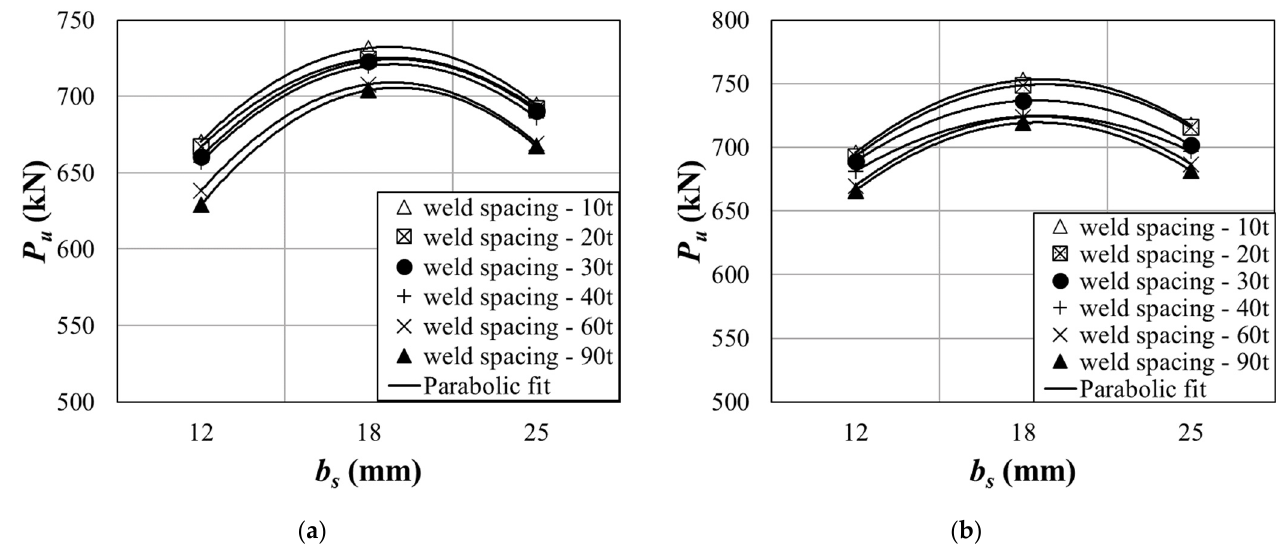
Figure 18. The effect of different stiffener widths on the performance of the circular CFDST . ( a ) t s = 2.3 mm, ( b ) t s = 2.8 mm.